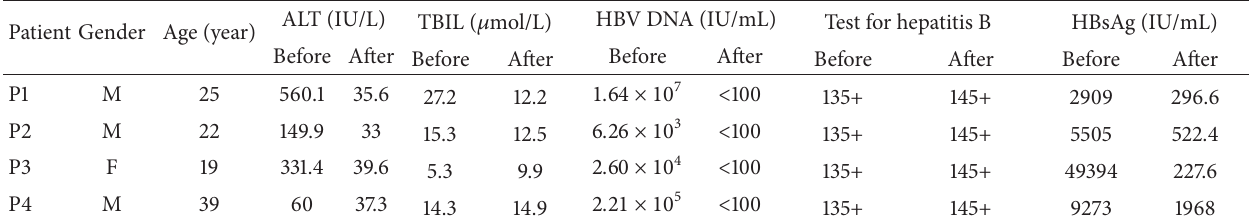
Table 1: Clinical characteristics of the enrolled patients.